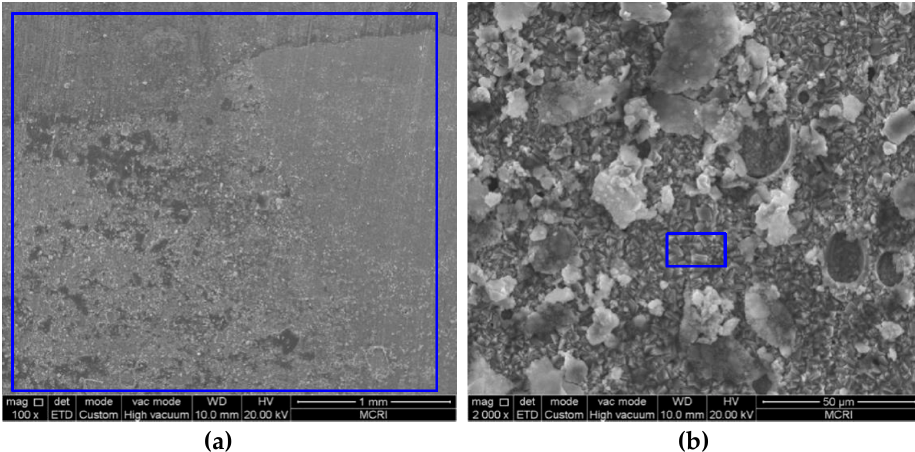
Figure 7. SEM images of the corrosion scales formed on the steel surface in 30% crude oil/brine mixtures at Pco 2 = 5.0 MPa: ( a ) ×100; ( b ) ×2000.